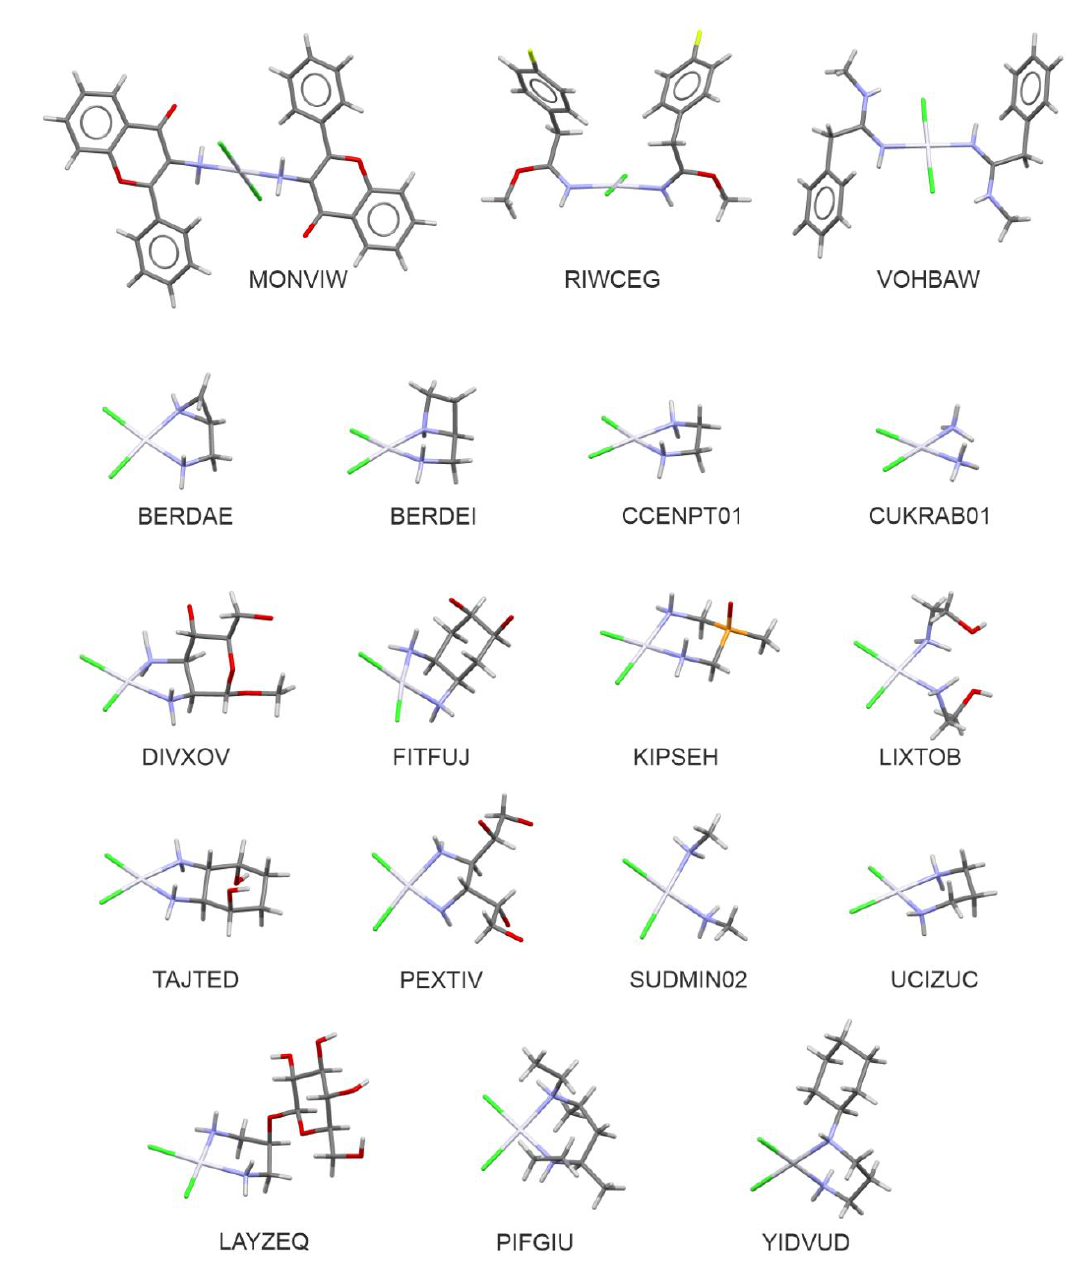
Figure 1. Molecular structures of biologically active analogues of cisplatin and transplatin (with the CSD refcodes).